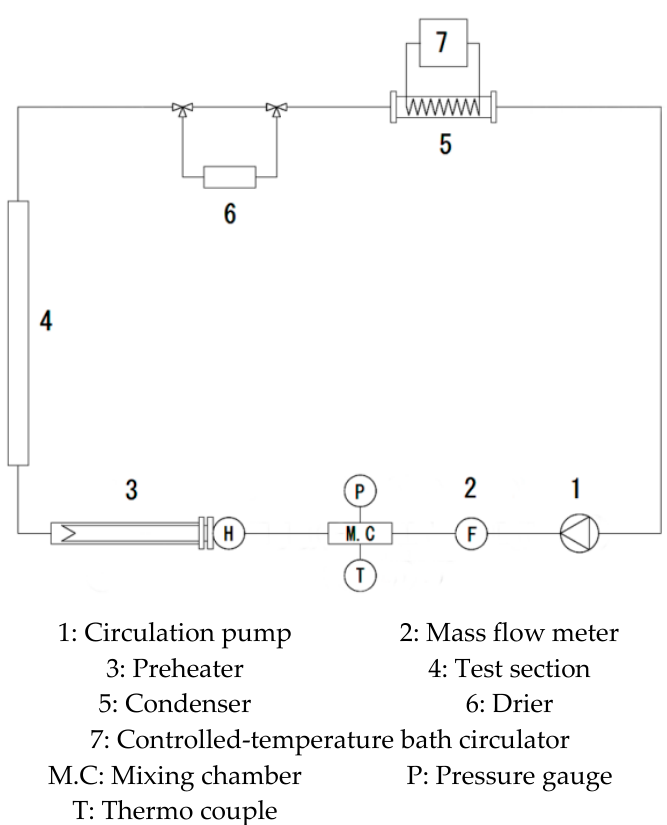
Figure 1. Schematic diagram of the experimental apparatus.